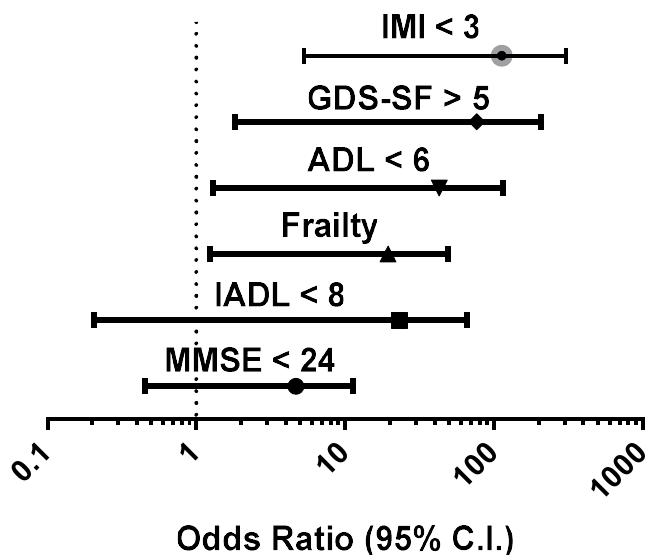
Figure 3. Odds ratios of factors associated with malnutrition (MNA score < 17) in a multivariate logistic regression model applied in the entire cohort studied. IMI, Italian Mediterranean index; GDS-SF, geriatric depression scale-short form; ADL, activities of daily living; IADL, instrumental activities of daily living; MMSE, mini-mental state examination.